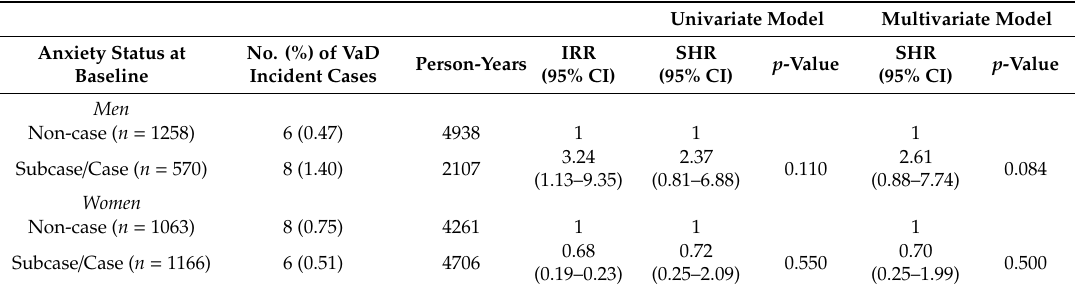
Table 2. Anxiety status and risk of VaD stratified by sex.